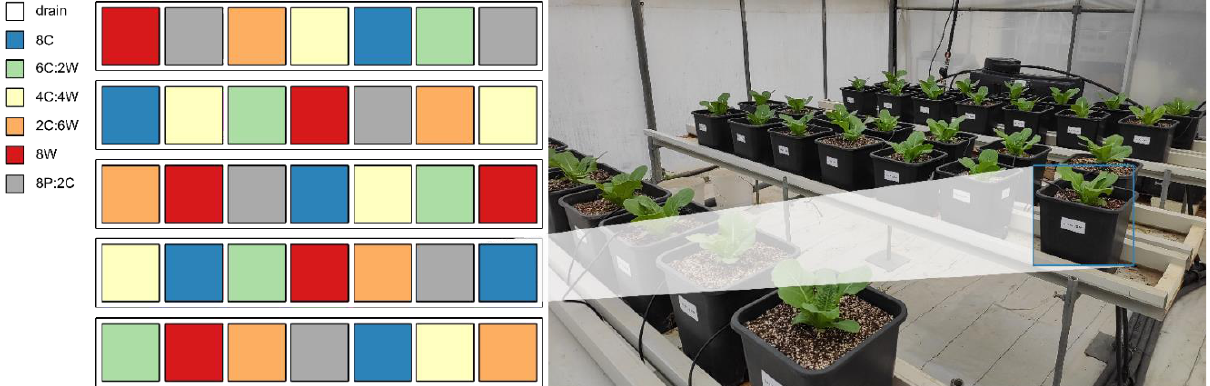
Figure 1. Experimental design (left) including all treatments (as shown in Table 2) and an additional control treatment (Perlite: Coir 8:2). On the right, a photograph of the experimental greenhouse during the experiment, with pot placement corresponding to the experimental design.